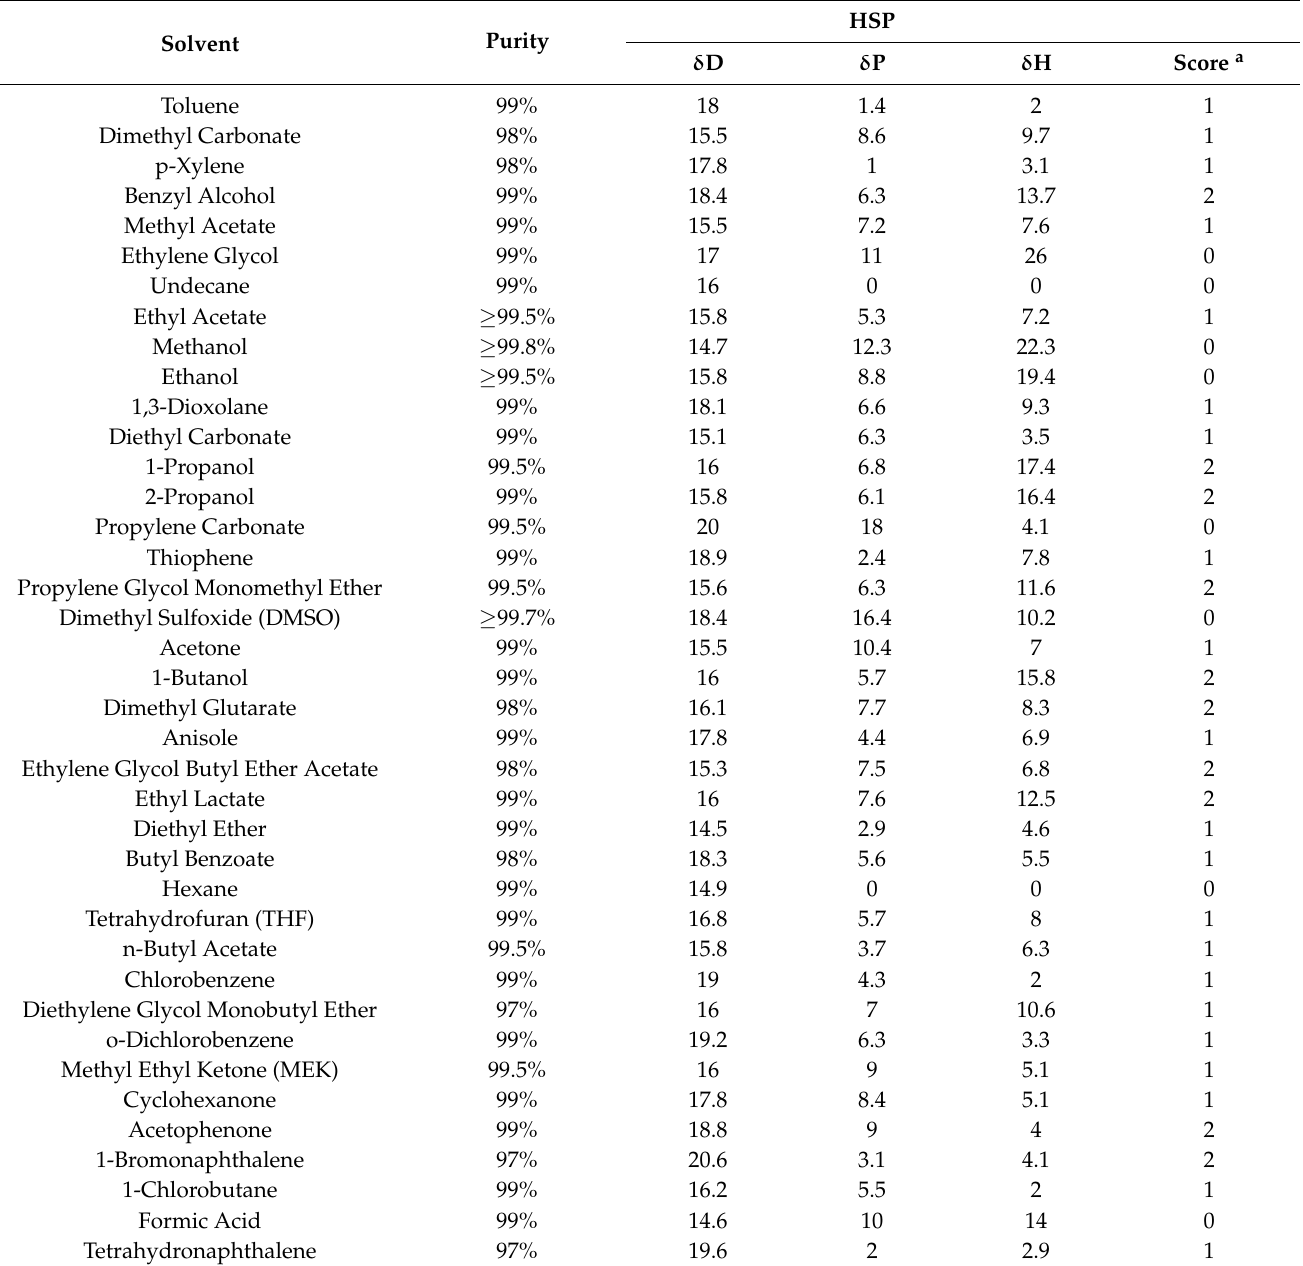
Table 1. The 39 solvents used in the dissolution test (t = 2